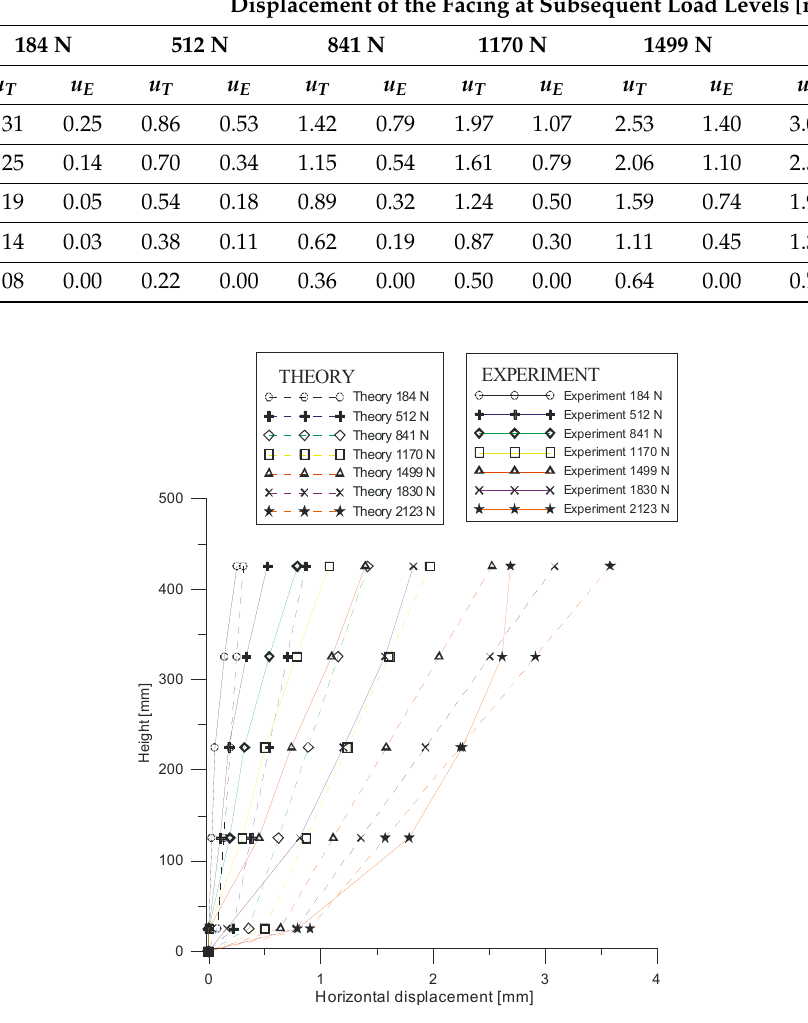
Figure 14. Comparison of experimental results with their analytical predictions.